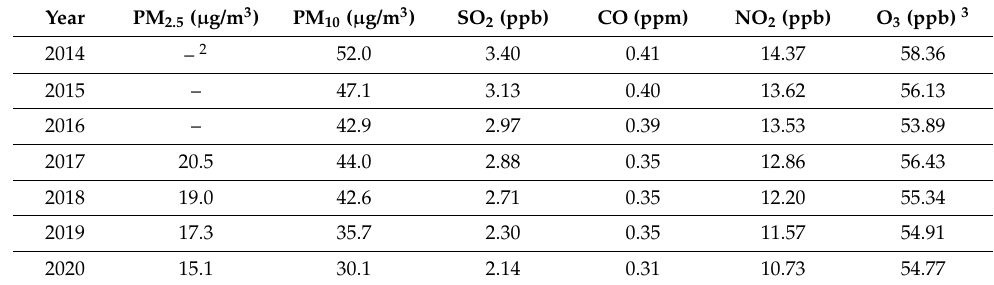
Table 3. Anual average concentrations of fine suspended particulates (PM 2.5 ), suspended particulates (PM 10 ), sulfur dioxide (SO 2 ), carbon monoxide (CO), nitrogen dioxide (NO 2 ) and ozone (O 3 ) during the period of 2014–2020 in the Taiwan area 1 .